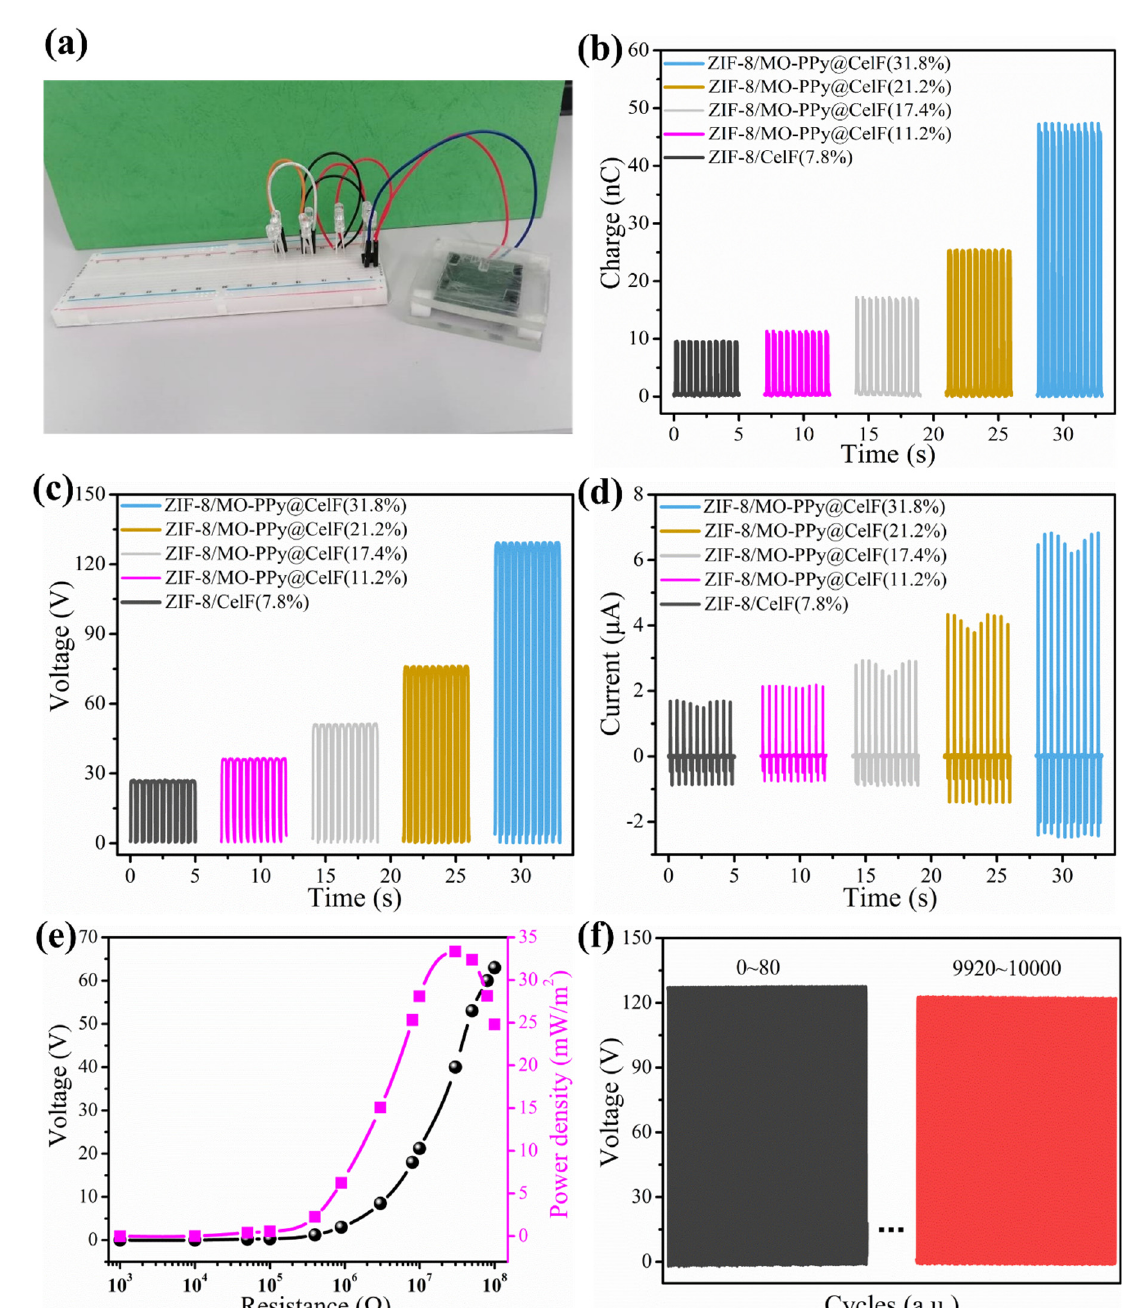
Figure 10. ( a ) Photograph of C-TENG, ( b ) transfer charge, ( c ) open-circuit voltage and ( d ) short-circuit current of C-TENG, ( e ) power output of C-TENG on external load resistances, ( f ) stability test of the C-TENG.